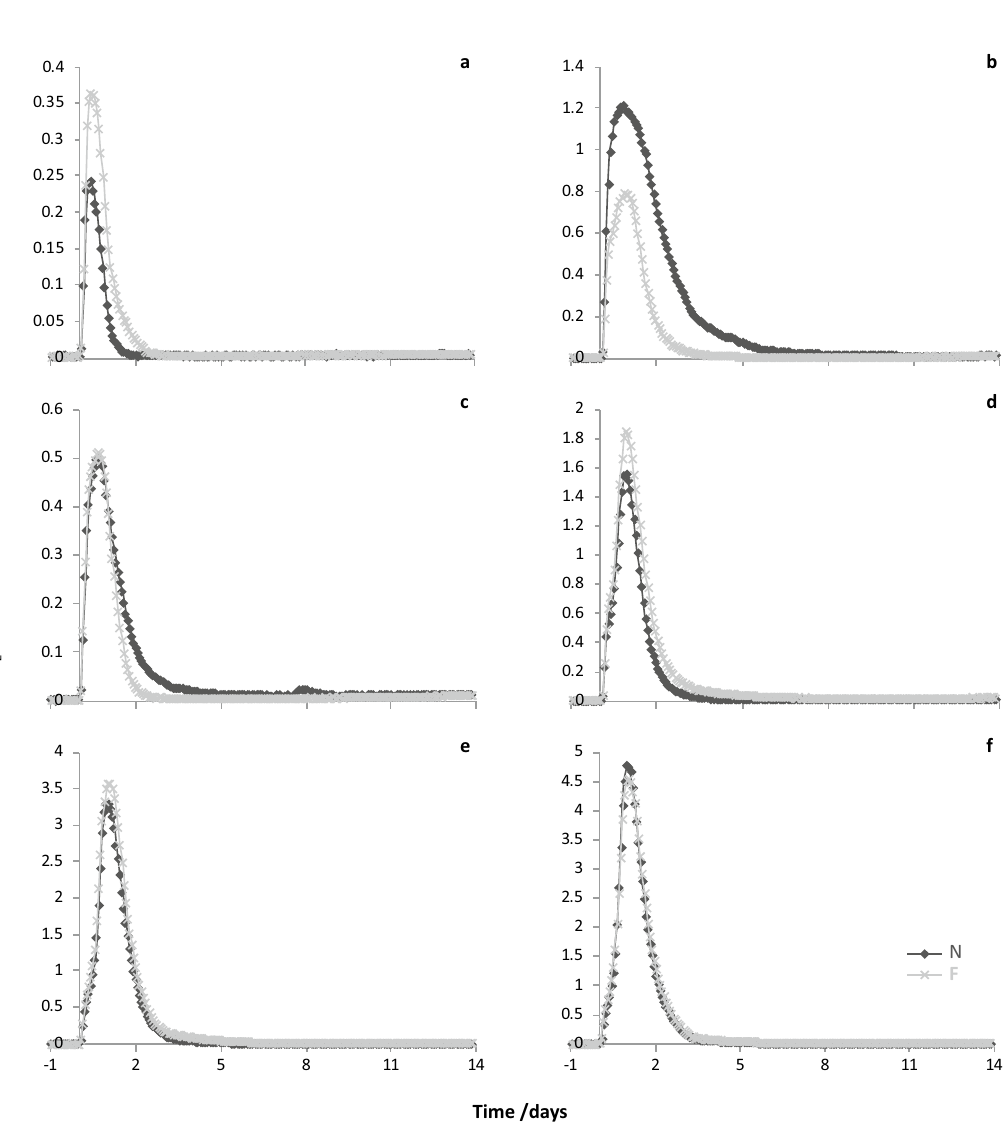
Figure 5. Graphs of paired N 2 O-N fluxes (ug g −1 dry soil d −1 ) from soil amended with non-freeze-dried (N; dark grey diamonds) or freeze-dried and rehydrated (F; light grey crosses) sheep urine samples in FD-1: ( a ) Sample ID 1, ( b ) 2, ( c ) 3, ( d ) 4, ( e ) 5, ( f )